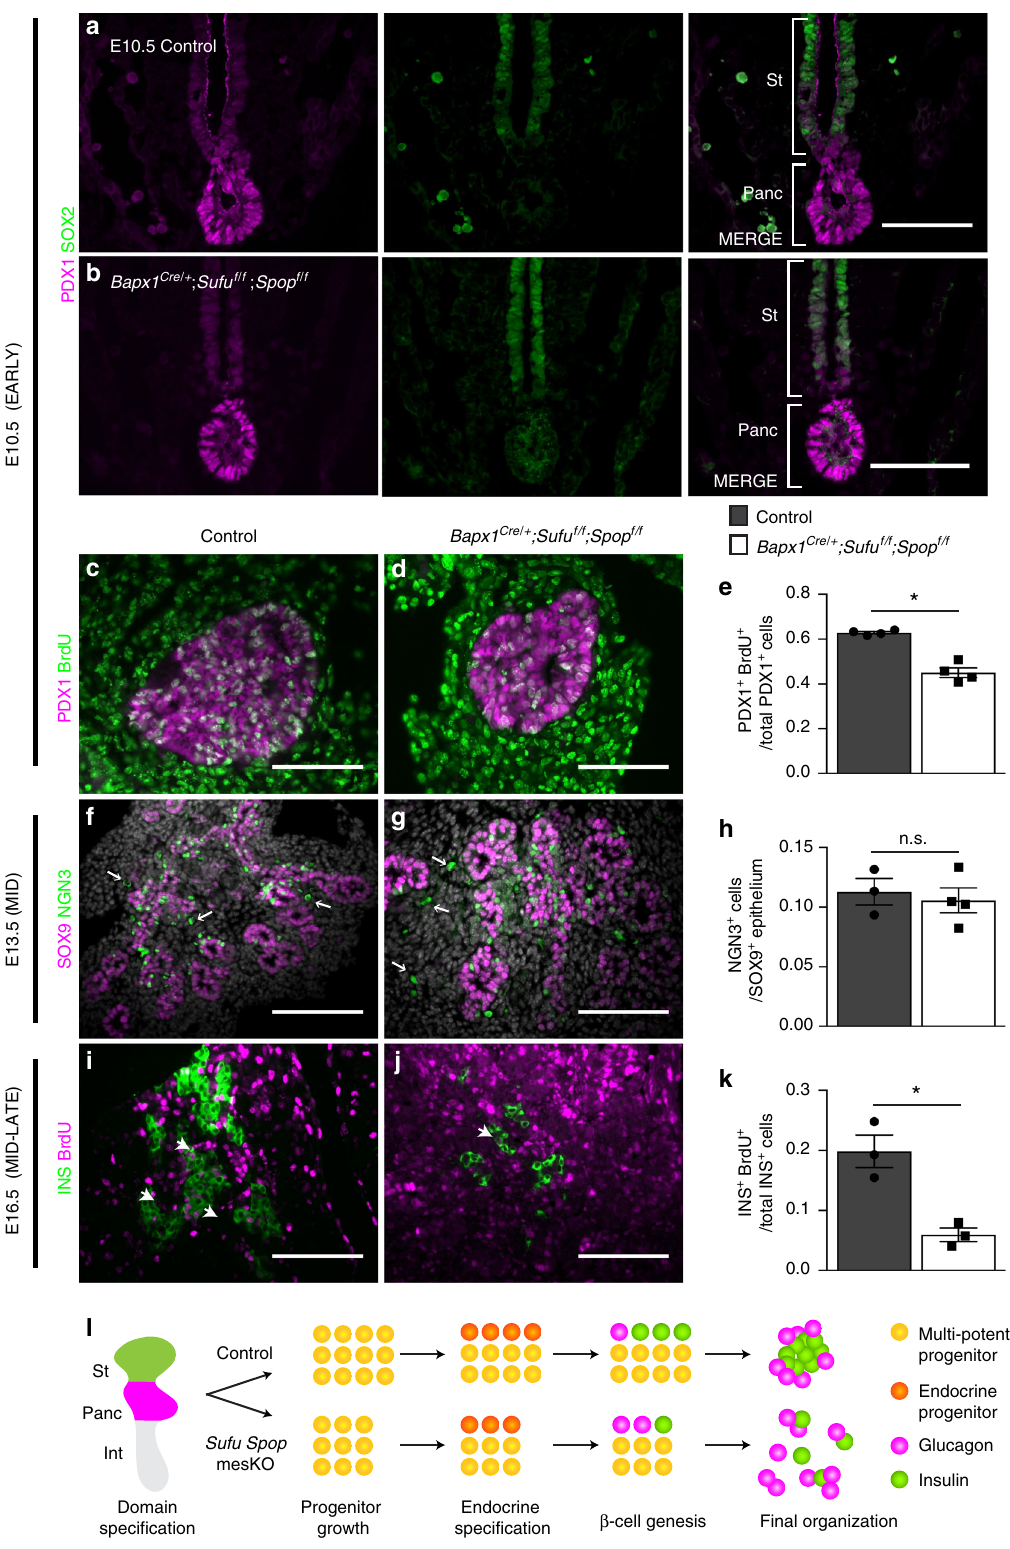
Loss of mesenchymal Hh signaling leads to ectopic branching . The analysis of Ptch LacZ mice implies active signaling in both the pancreatic epithelium and mesenchyme 16 . Since epithelial-speci fi c inhibition of Hh signaling led to milder defects than those found with global inhibition 16,17 , we hypothesized that active signaling is also required in the pancreatic mesenchyme. To address this, we